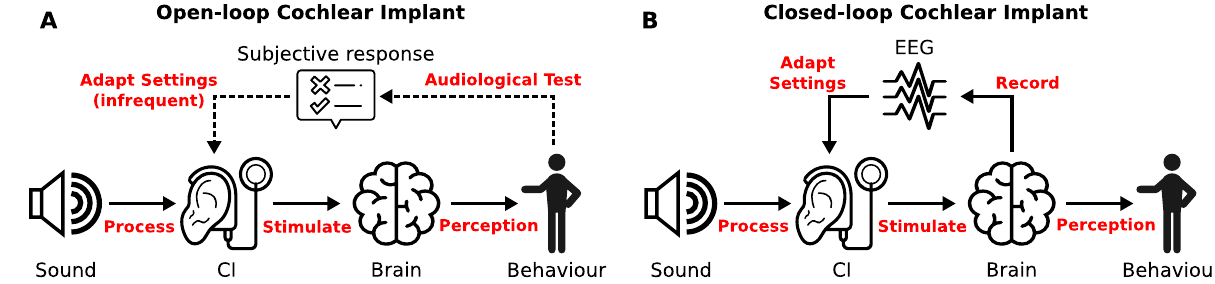
Figure 6. ( A ) Currently, CIs operate as an open-loop system for the majority of the time. Behavioural feedback from the user is used to fit the device settings during infrequent visits to an audiologist. ( B ) Neural feedback can be used to close the loop. This eliminates the need for behavioural feedback, and can happen continuously if an EEG system is integrated with the CI. Image composed with icons from thenounproject.com,